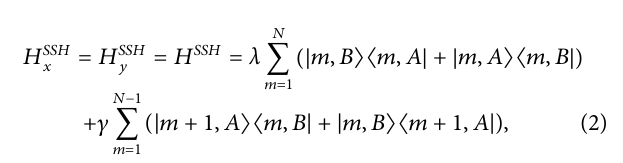
Frontiers in Physics |